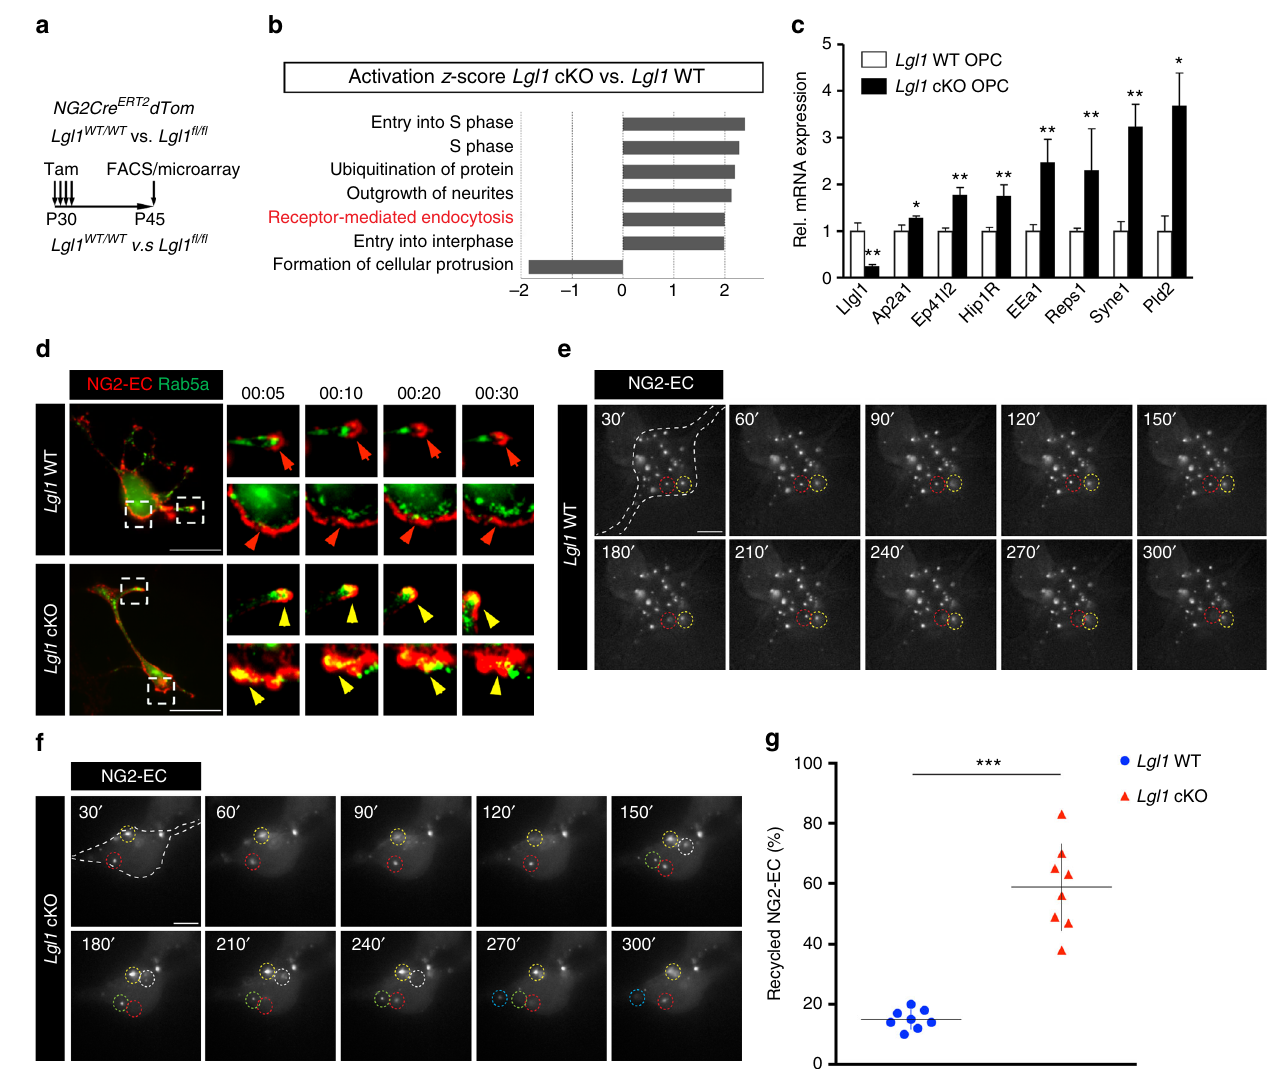
Fig. 7 Lgl1 negatively regulates internalization and recycling of NG2 in OPC. a Schematic illustration of the experimental approach assessing global changes in gene expression by microarray in Lgl1 WT vs. Lgl1 cKO OPC. FACS sorted red fl uorescent PDGFR α + O4 − cells. b Bar graph of ingenuity pathway analyses (IPA) of Lgl1 WT vs. cKO OPC. Receptor-mediated endocytosis pathway is amongst the upregulated pathways in Lgl1 cKO cells. c Validation by q-RT-PCR for mRNA encoding receptor-mediated endocytosis regulators that were differentially expressed in Lgl1 cKO cells as determined by microarray analyses. OPC were derived from the corpus callosum of GFAP-Cre , Tom , Lgl1 wt/wt and, GFAP-Cre , Tom , Lgl1 fl / fl mice. Data represented as mean ±s.e.m. n = 6 Lgl1 WT and 6 Lgl1 cKO animals (* p < 0.05, ** p < 0.01, Mann – Whitney test). d Steady-state frames of time lapse (1 frame/ 10 min) of NG2-EC (red) and early-endosome marker Rab5a (green) in Lgl1 cKO and WT OPC. Note that NG2 stays mostly at the membrane in Lgl1 WT cells (red arrows), whereas it co-localizes with the early endosome in the cytoplasm of Lgl1 cKO OPC (yellow arrows). Scale bar: 20 µ m. e , f Frames illustrating time lapse experiment under TIRF microscopy. Pictures are acquired each 30 seconds as soon as cells were exposed to differentiation conditions. Each white puncta in focus represents labeled NG2-EC docked at the membrane. Individual recycled puncta are highlighted with dashed circles of different colors. Note that in Lgl1 cKO cells, the majority of the labeled NG2 is internalized and recycled to the membrane whereas in WT cells, the majority of NG2 puncta retains a stable localization at the membrane. Scale bars: 10 μ m. g Graph representing the quanti fi cation of NG2 recycling at the membrane throughout the fi rst 5 min of differentiation conditions. Data represented as mean ± s.e.m. n = 3 cells per genotype, three independent experiments (*** p < 0.005, Student's t